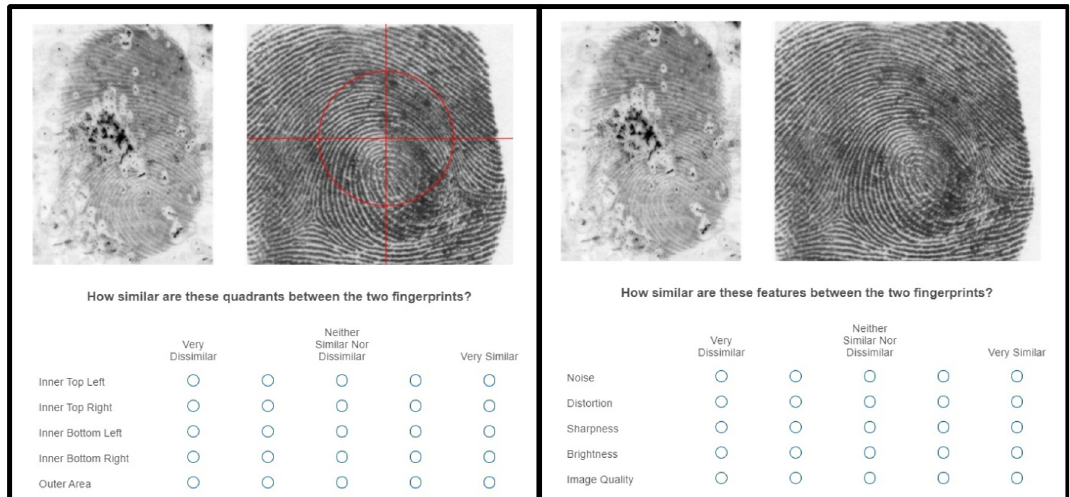
Fig 1. An example trial from the feature-comparison (left) and control (right) conditions. The red grid illustrated in the left panel was overlaid to highlight each of the five areas participants in the feature-comparison condition were asked to rate (i.e., inner upper left, inner upper right, inner lower left, inner lower right, and outer area).